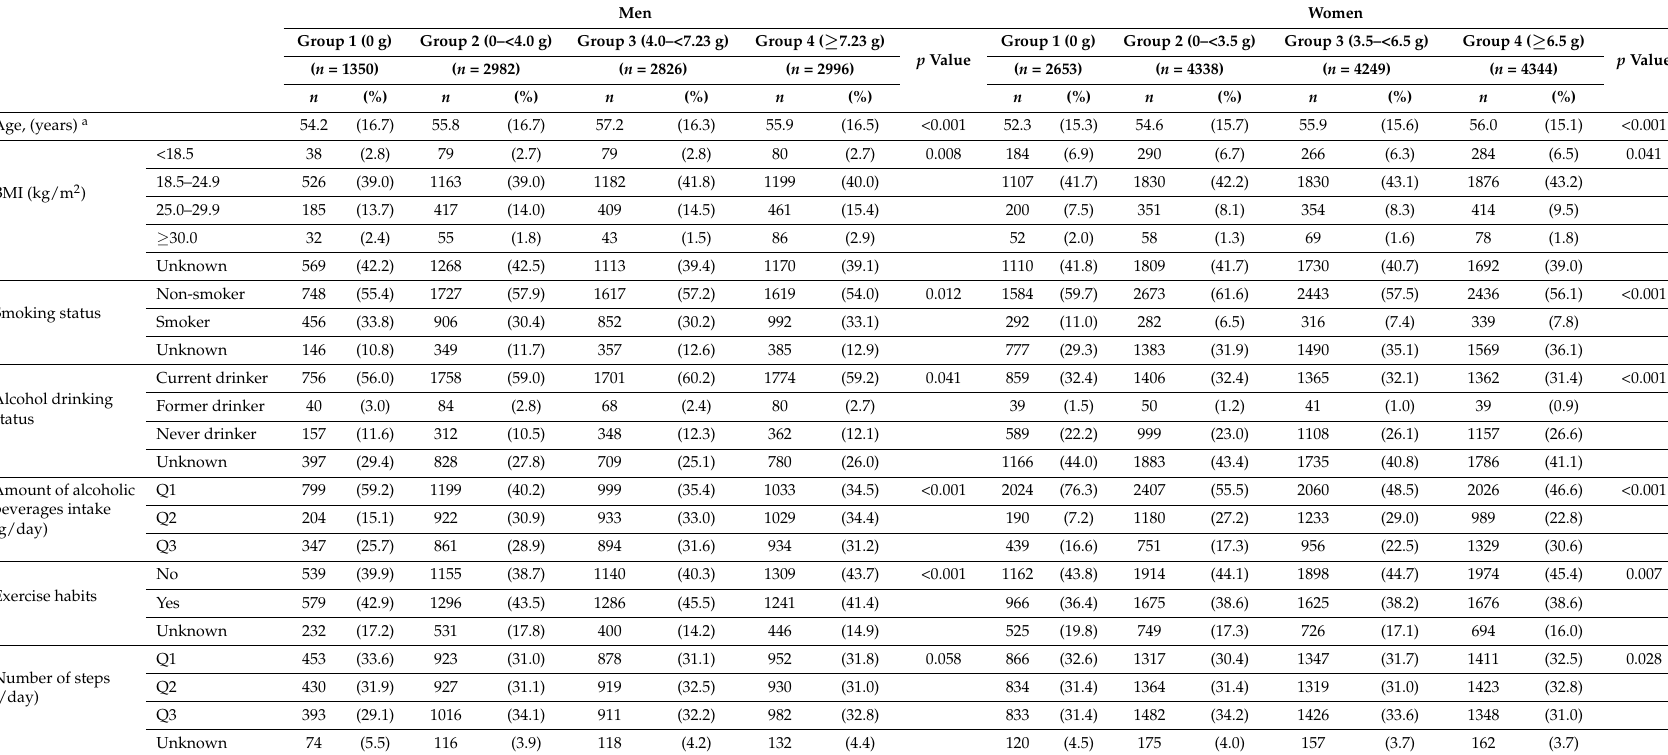
Table 1. Demographic characteristics of the participants according to the portion size of soy